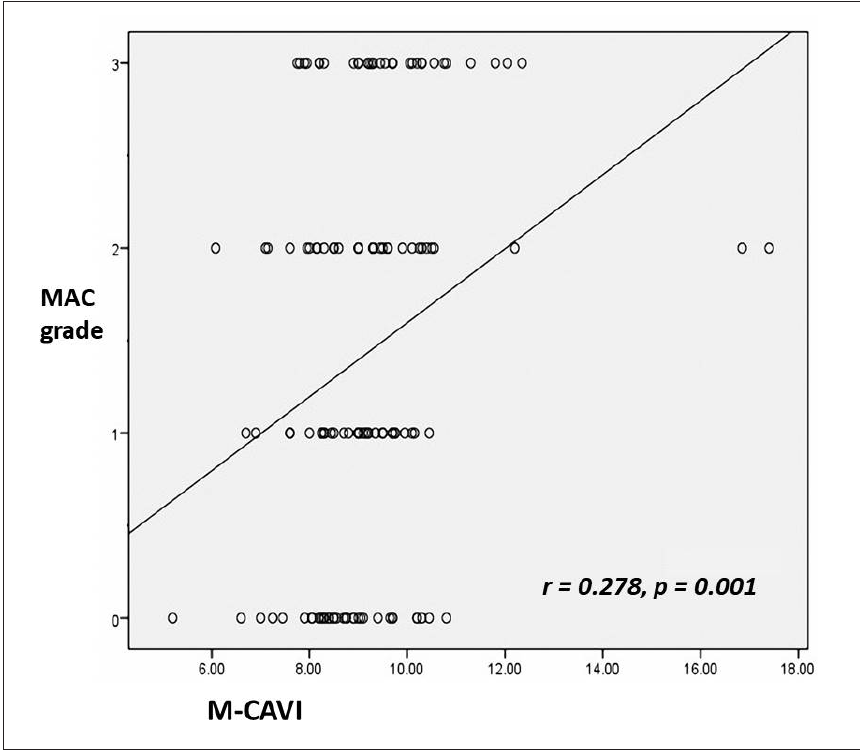
Figure 3. Graph of correlation analysis for MAC grades in all patients with M-CAVI. M-CAVI, mean cardio-ankle vascular index; MAC, mitral annular